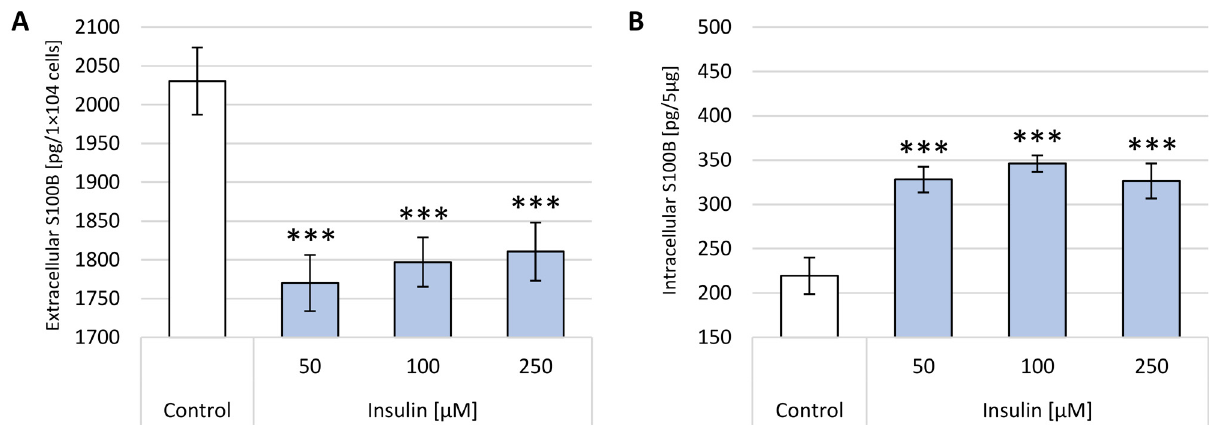
Figure 7. S100B protein concentration in neuron-like cells after incubation with different insulin concentrations (50, 100 and 250 µM). Control—untreated cells. ( A ) Extracellular S100B levels per 1 × 10 4 cells; ( B ) intracellular S100B levels per 5 µ g of total cellular protein concentration. Statistically significant differences compared to the untreated neuron-like cells: *** p <